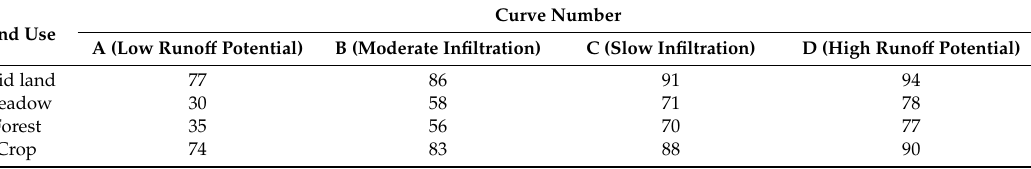
Table 1. Curve number for di ff erent land uses in the Soil Conservation Service Curve Number (SCS-CN)